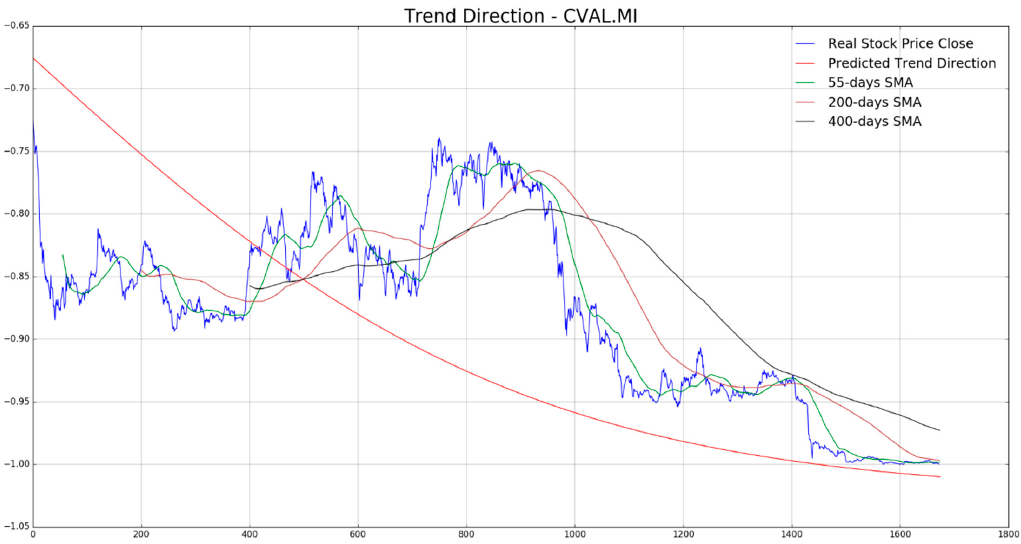
Figure 9. CVAL.MI Trend Direction (red) and SMA.